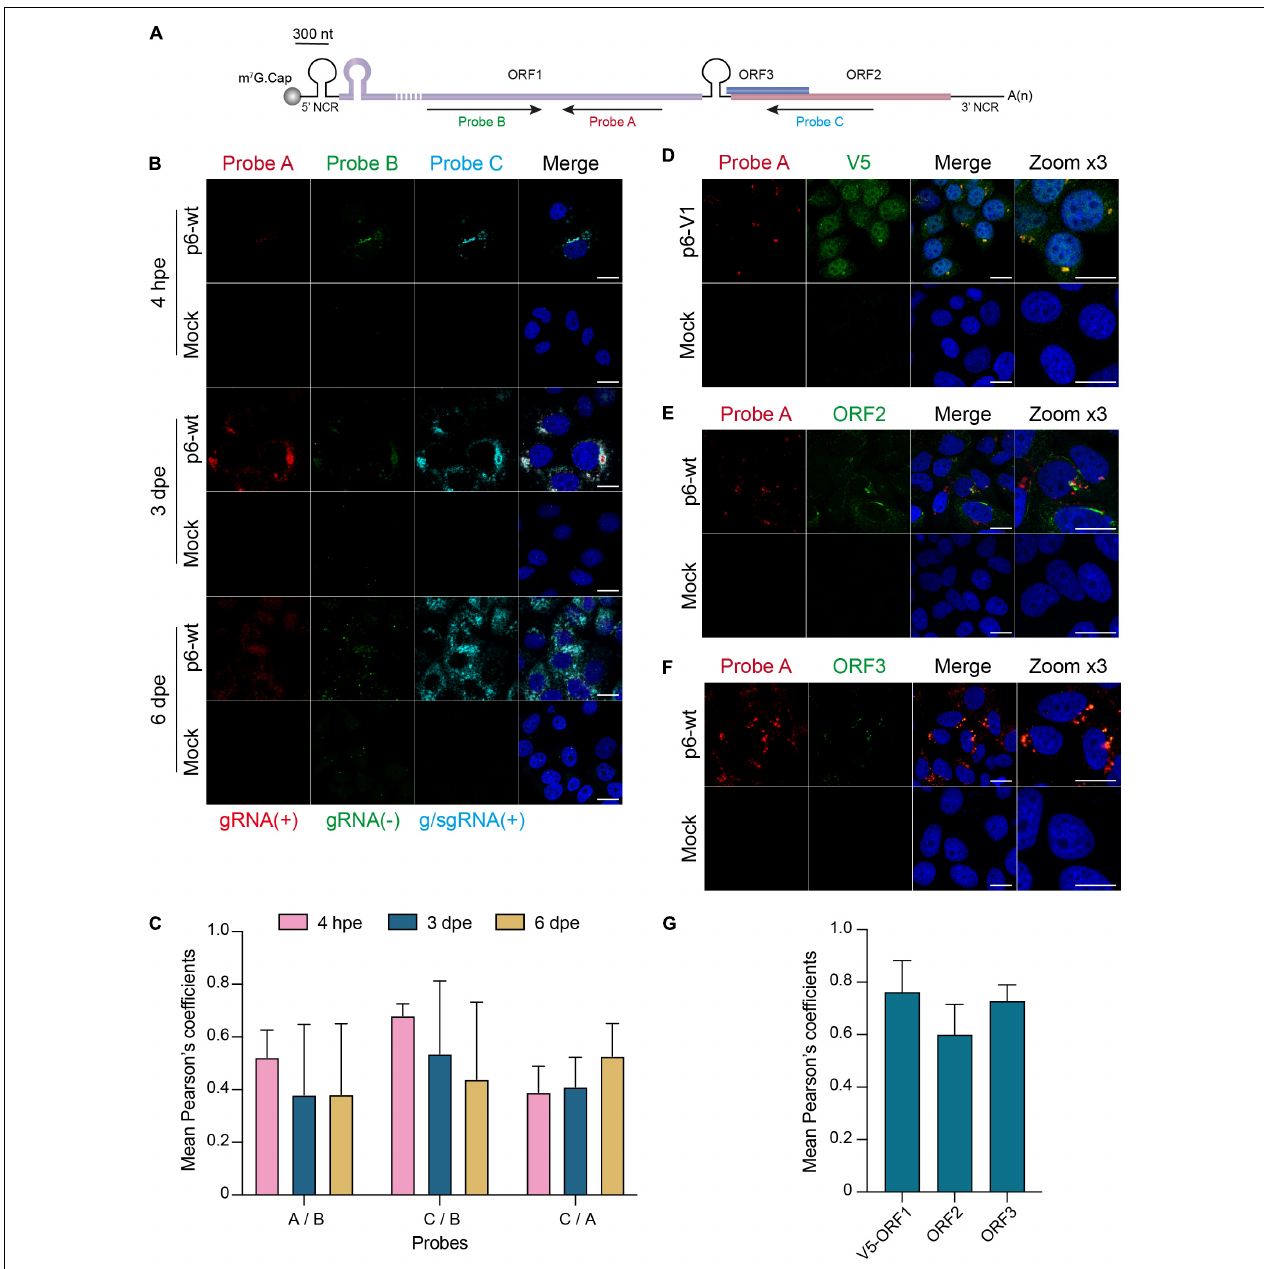
FIGURE 8 | In situ labeling of positive- and negative-sense HEV RNAs. PLC3 cells were electroporated with untagged (p6-wt) or V5-tagged (p6-V1) p6 strains. Cells were grown on coverslips, fixed at 4 hpe, 3 and 6 dpe and processed for in situ RNAscope R (cid:13) hybridization. Cell nuclei were stained with Dapi (blue). Images were taken on a confocal microscope. Mock-electroporated cells served as negative control. Scale bar = 20 µ m. (A) Schematic overview of the RNAscope R (cid:13) probe location. Probe A targets the positive-sense genomic RNA and is located in the RdRp domain of ORF1 (purple). Probe B targets the negative-sense RNA and is also located in the RdRp but does not overlap with probe A. Probe C targets the positive-sense subgenomic RNA, by hybridizing at the ORF3 (blue) / ORF2 (red) overlap. The full-length of the ORF1 protein cannot be represented at the scheme scale (purple dashed lines). (B) PLC3 cells electroporated with the p6-wt strain were sequentially stained with probes A [red, gRNA(+)], B [green, gRNA(-)] and C [cyan, g/sgRNA(+)] at 4 hpe, 3 and 6 dpe. gRNA(+), positive-stranded genomic RNA; gRNA(-), negative-stranded genomic RNA; g/sgRNA(+), positive-stranded genomic and subgenomic RNAs. (C) Immunofluorescence images of whole PLC3 cells electroporated with p6-wt and co-labeled with probes A, B and C were used to determine PCC using JACoP plugin from ImageJ software. PCC means ( ± standard deviation) were calculated from 30 analyzed whole cells. (D–F) Three dpe, PLC3 cells electroporated with the p6-V1 construct were stained with probe A (red) and (i) the anti-V5 antibody [green, (D) ], (ii) the anti-ORF2 [green, 1E6, (E) ] or (iii) the anti-ORF3 [green, (F) ]. (G) Regions of interest (ROI) were drawn around the perinuclear nugget-like structures on images taken from PLC3 cells electroporated with p6-V1 or p6-wt and co-labeled with probe A and anti-V5, anti-ORF2 or anti-ORF3 antibody. Twenty ROI were used to calculate mean PCC ( ± standard deviation) between probe A and V5-tagged ORF1 (V5-ORF1) labeling or probe A and ORF2 labeling (ORF2) or probe A and ORF3 labeling (ORF3) using JACoP plugin from ImageJ software.